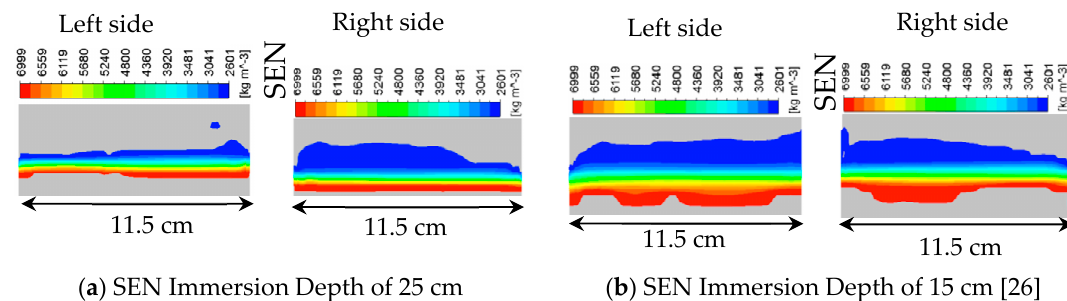
Figure 9. Enlarged interface region in Figure 8, with a density range from pure slag to pure steel.